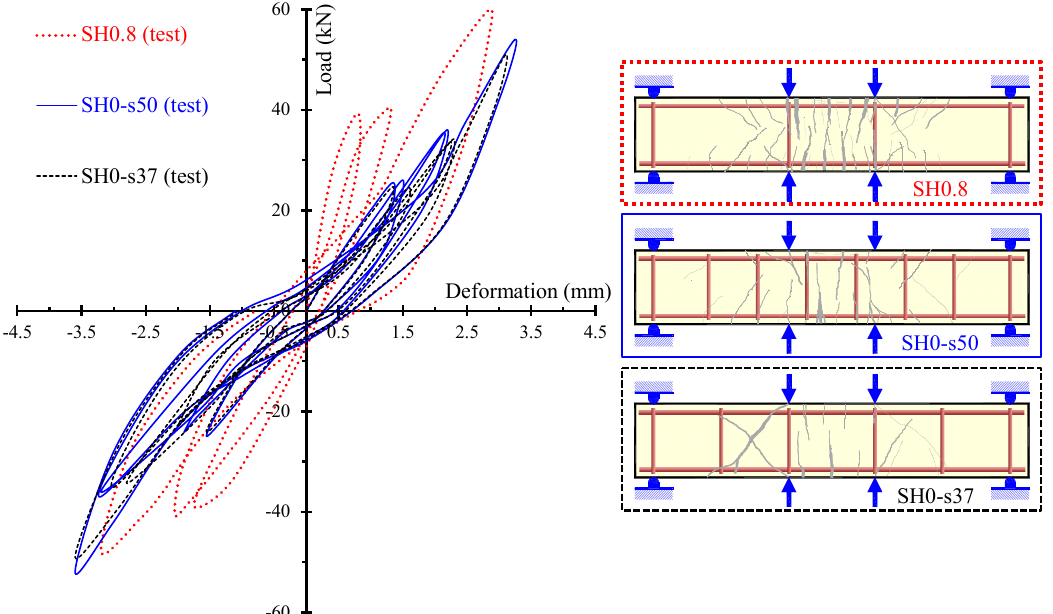
Figure 18. Potential replacement of common closed steel stirrups with short steel fibers.